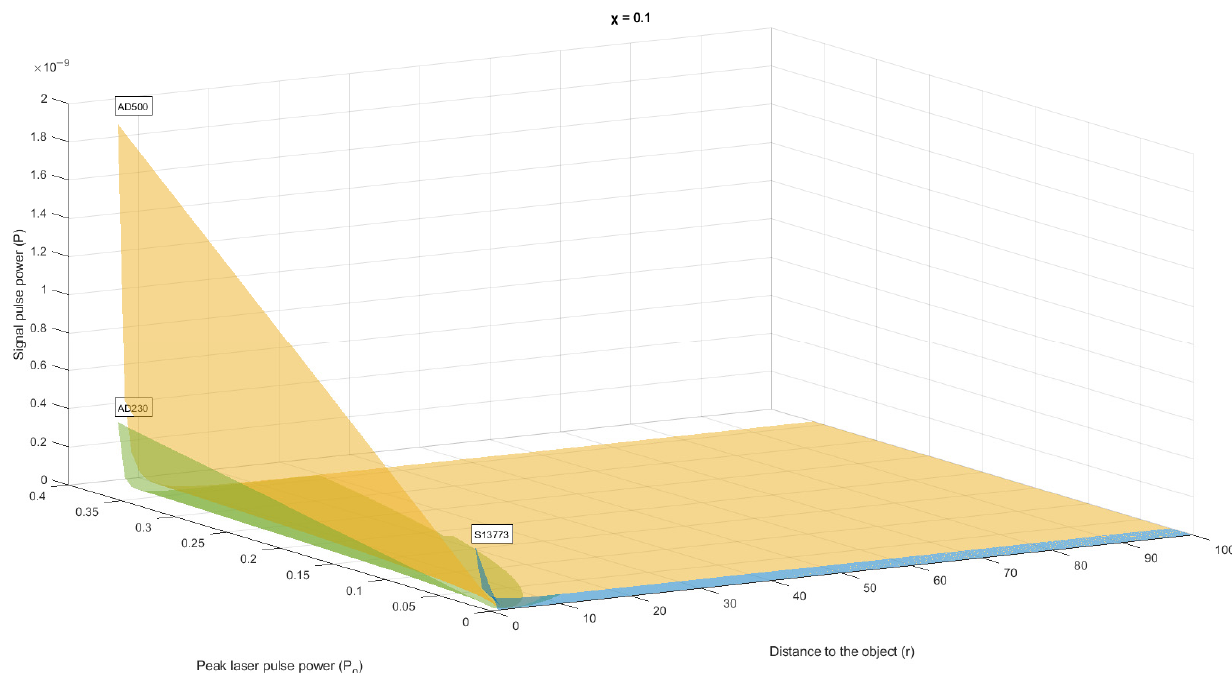
Figure 7. The dependence of the received optical power on the distance and pulse power of the LiDAR for three types of detectors (AD500, AD230 and S13773) in the media with optical loss factor χ 1 = 0.1.